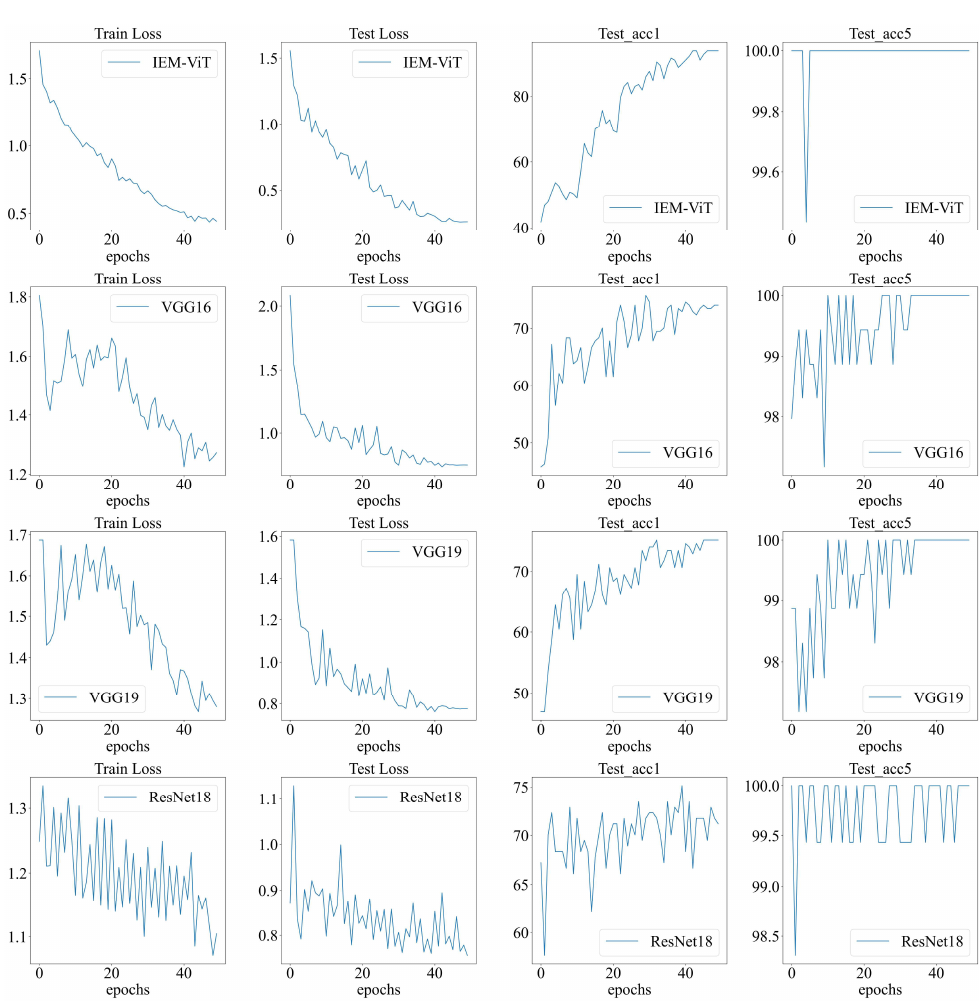
Table 2. Tea disease recognition results of different models.